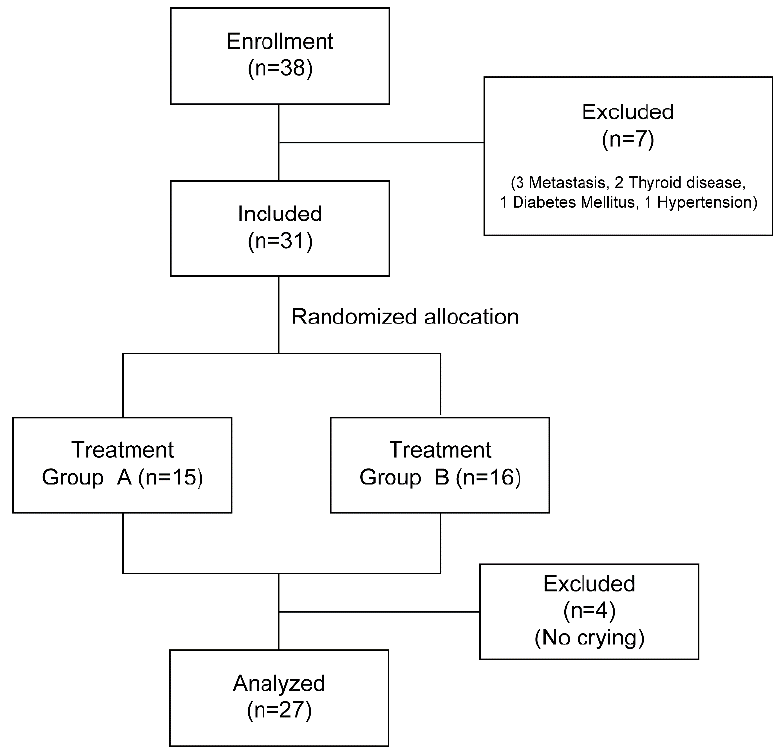
Figure 2. Flow diagram of sampling.